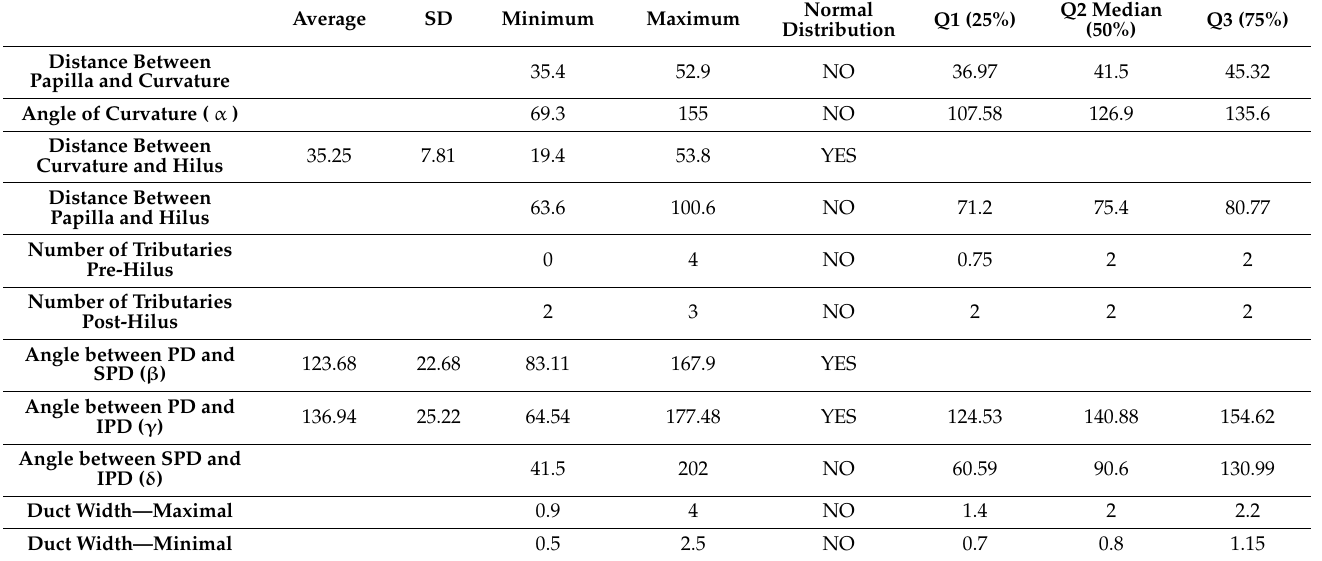
Table 1. Features of the parotid